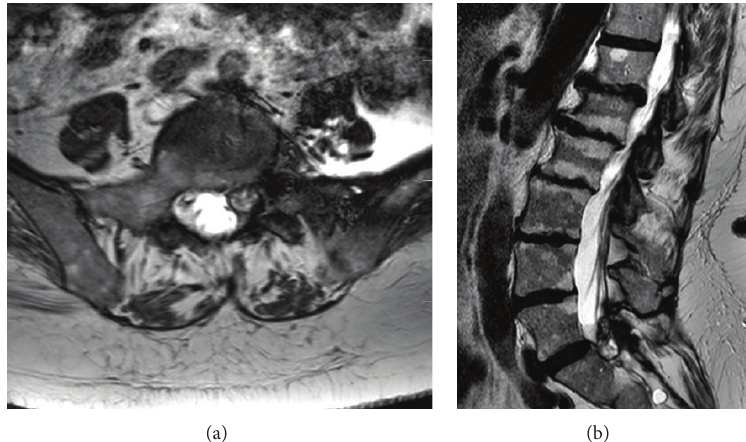
Figure 1: Axial (a) and sagittal (b) T2 weighted images showing the cyst with associated blood products at the left L5/S1 level.